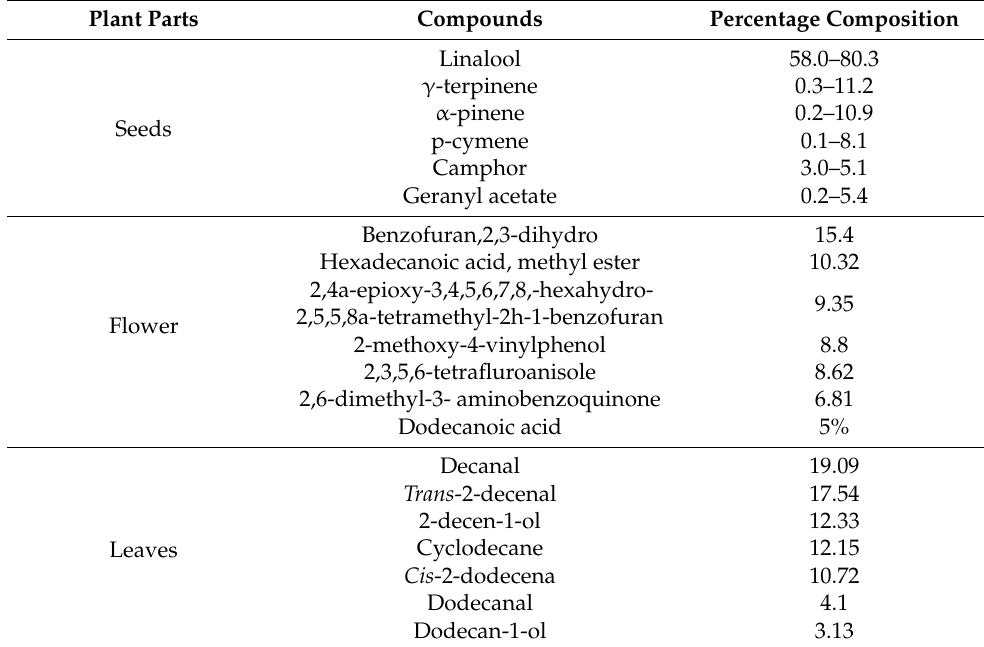
Table 3. Composition variation of essential oil from various parts of C. sativum . Plant